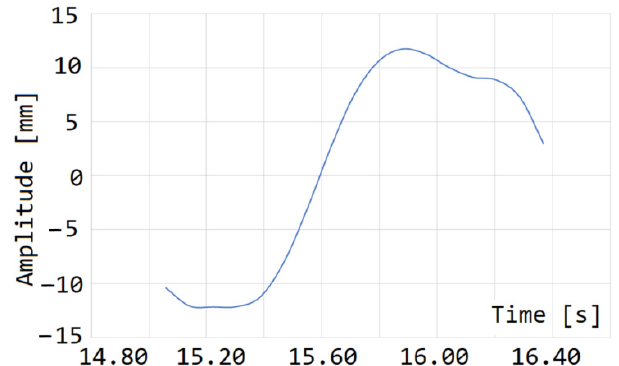
Figure 22. An increase of the interval between the 15th and 17th seconds.